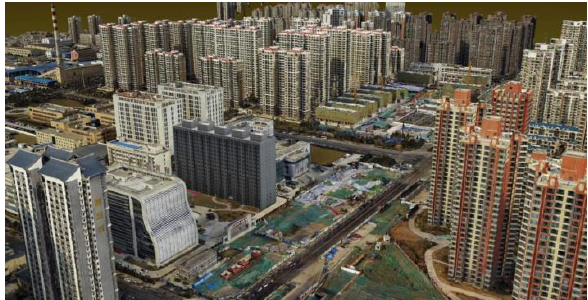
Figure 5.Three-dimensional model of the proposed building